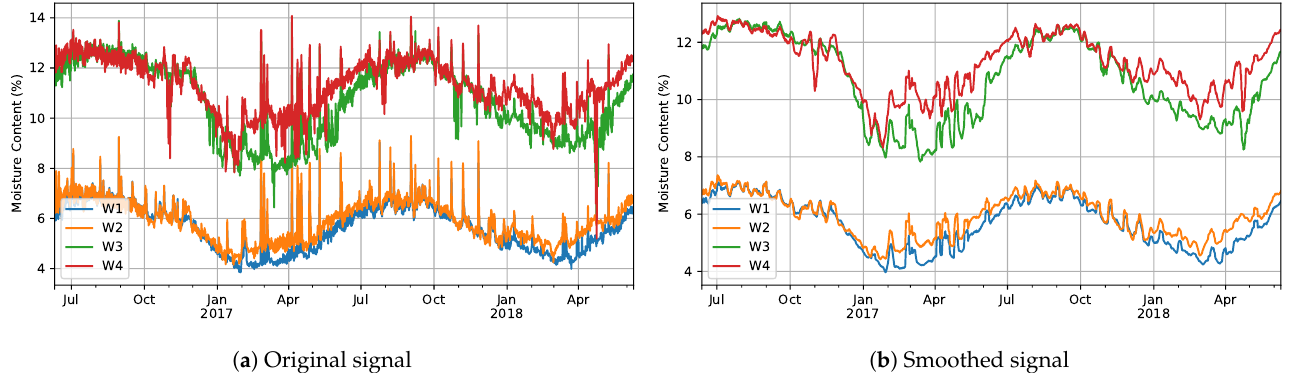
Figure 8. Comparison of original and smoothed signals from windows after applying a moving average filter.